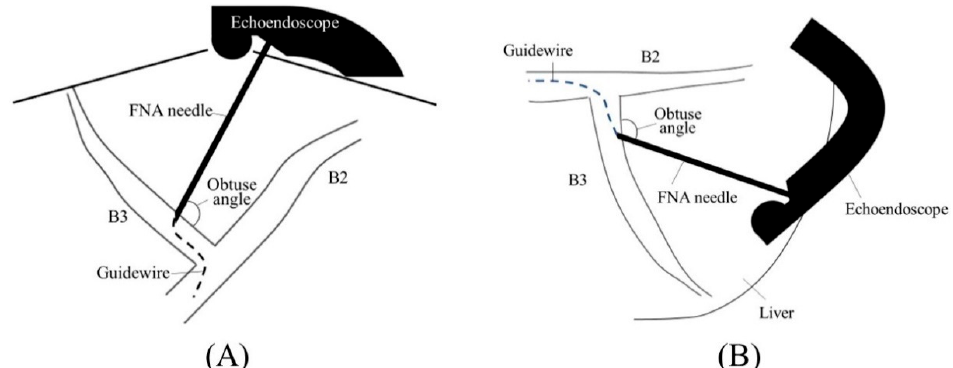
Figure 3. Optimal echoendoscope position in B3 puncture. Pushing a scope while turning the large wheel upward rotates the EUS image clockwise and makes the angle between a needle and the bile duct on the hilar side obtuse, making a guidewire manipulation toward the hilar region easy ( A ). Fluoroscopic image ( B ).